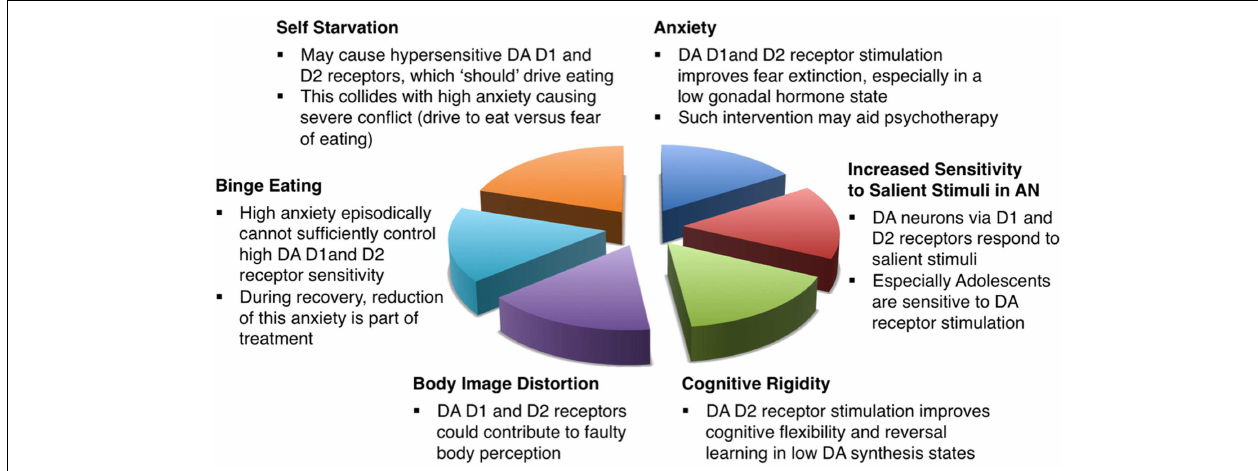
FIGURE 1 | Schematic description how dopamine D1 and D2 receptors could be involved in the pathophysiology and treatment of anorexia nervosa .